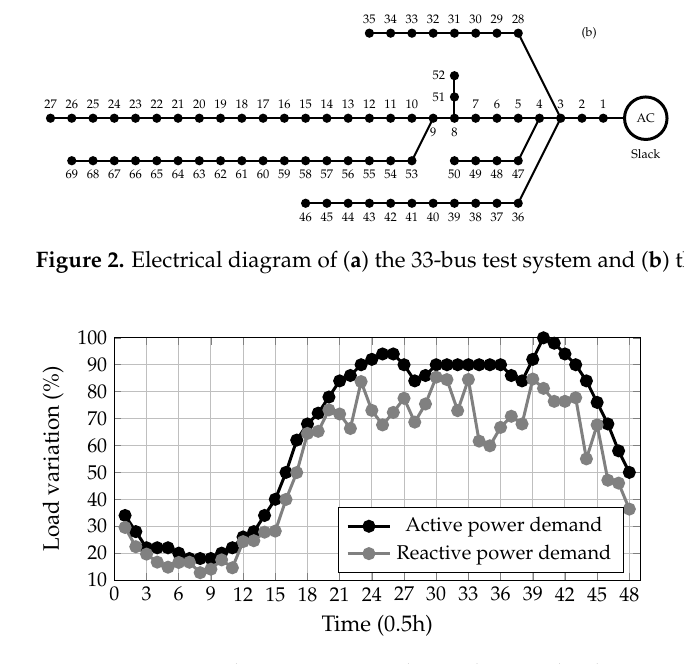
Figure 3. Active and reactive power demand in a Colombian EDS